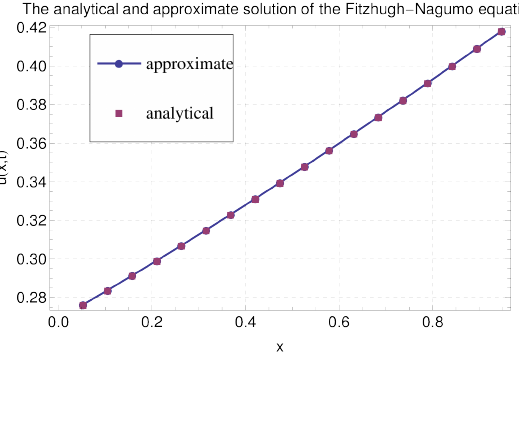
Fig. 4. Solution of the Fitzhugh-Nagumo equation